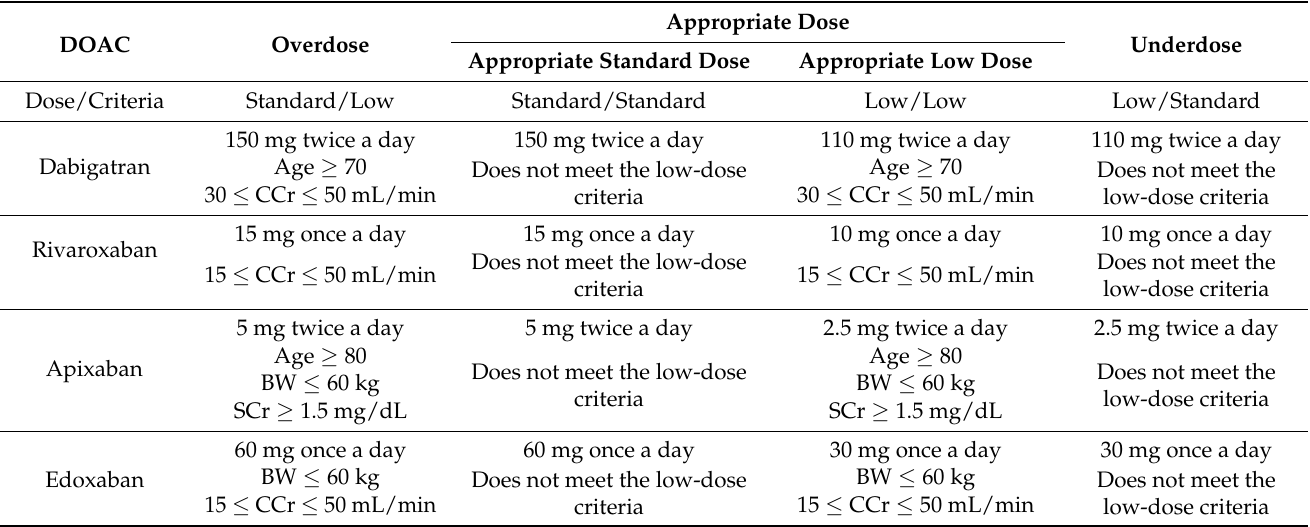
Table 2. Assessment of the DOAC